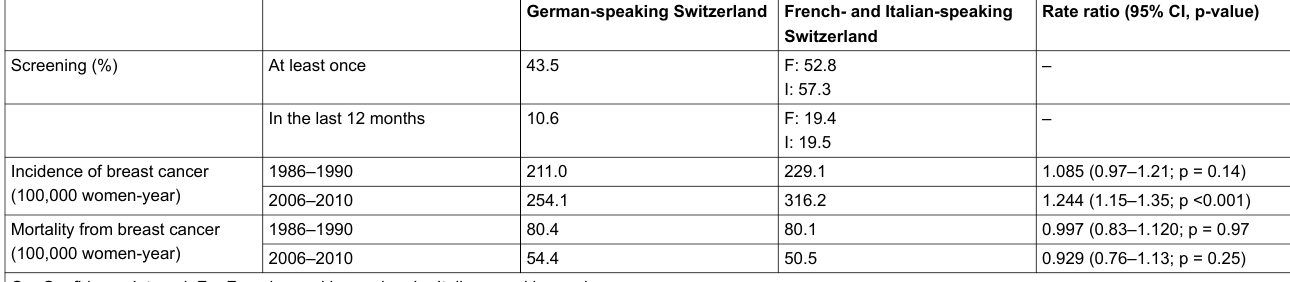
Table 1: Breast cancer mortality rates in women aged between 50 and 69 years (recommended ages for screening). The periods from 1986 to 1990 and from 2006 to 2010 represent, respectively, the periods before and after the establishment of organised screening programmes in Switzerland. Rate ratios and their respective 95% CIs have been calculated in order to compare mortality rates of two major regions of Switzerland (German-speaking vs French and Italian-speaking). There is no difference in mortality between the two major regions of Switzerland despite the increased incidence of diagnosed breast cancer in the French and Italian- speaking regions that could be secondary to the higher screening coverage. German-speaking Switzerland French- and Italian-speaking Rate ratio (95% CI, p-value) Switzerland Screening (%) At least once